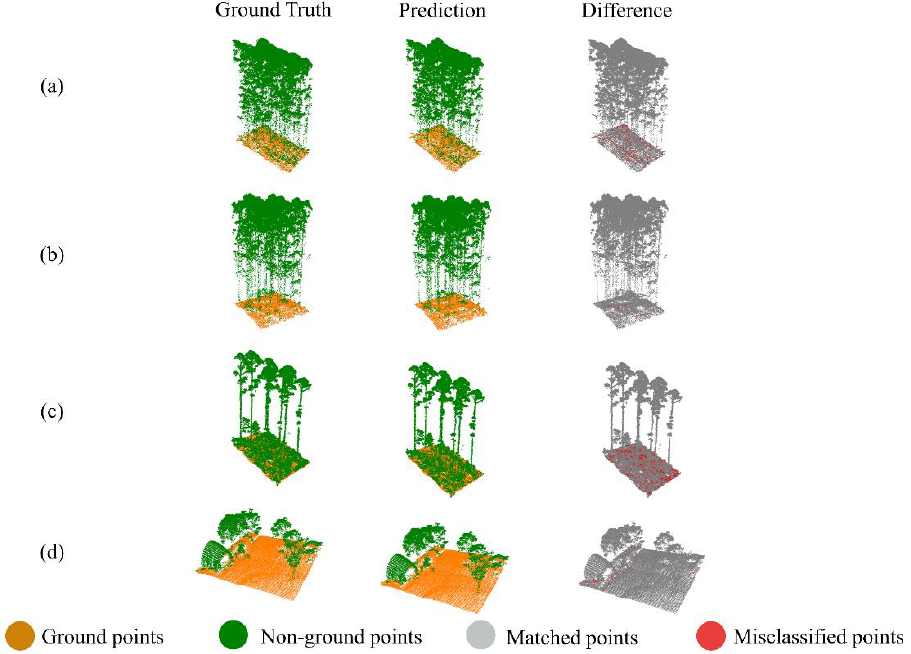
Figure 5. Ground filtering result of the Terrain-net on test dataset. The four representative forest environment types in the dataset are shown from ( a – d ), in order: dense vegetation with slope, dense vegetation with flat terrain, sparse vegetation with slope, and sparse vegetation with flat terrain.